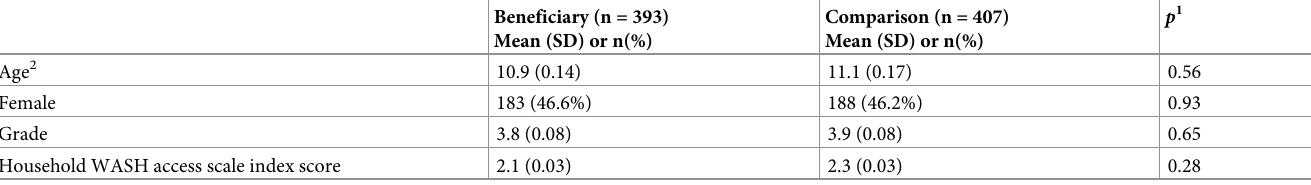
Table 1. Demographic characteristics of study population.